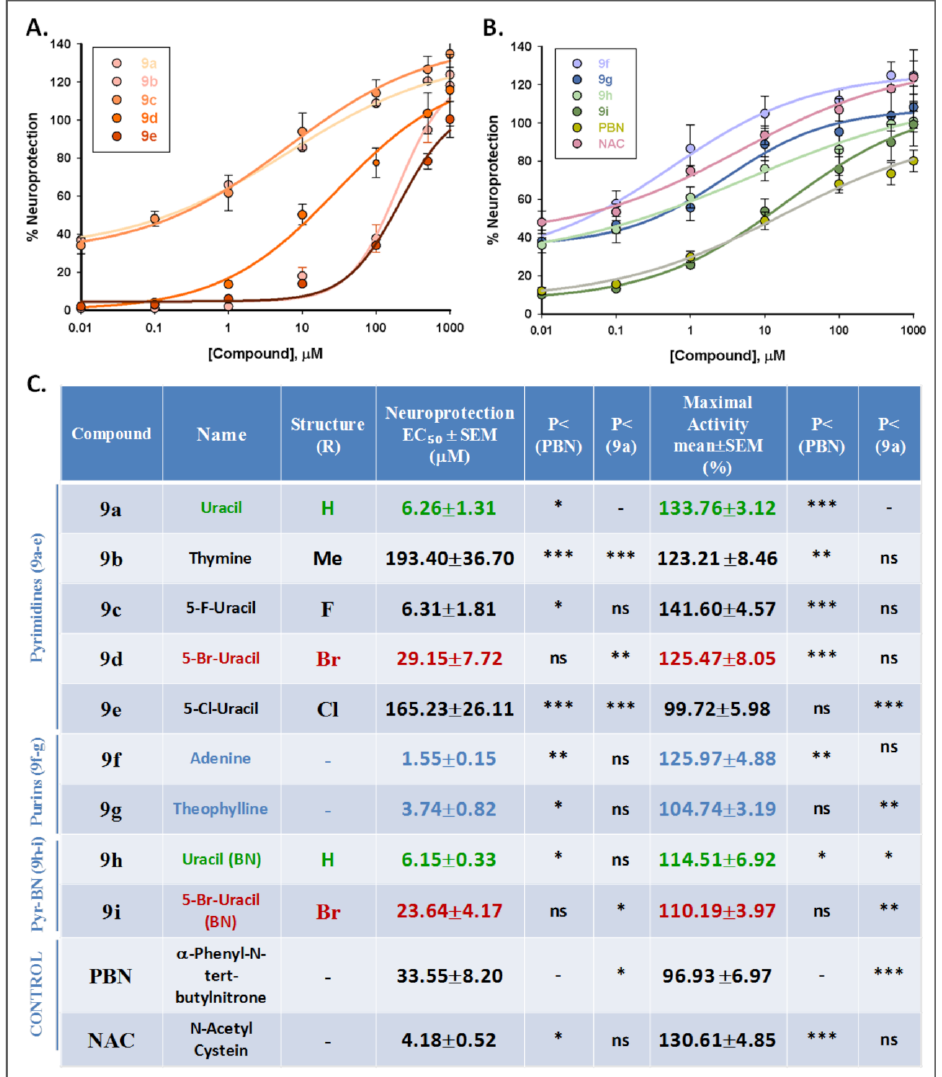
Figure 4. Neuroprotective effects of nitrones 9a – 9i , PBN , and NAC against metabolic cell damage induced by IR treatment in SHSY5Y human neuroblastoma cells. ( A , B ) Concentration-response curves indicating the percent of neuroprotection of different nitrones, 9a – e ( A ), and nitrones 9f – i , PBN , and NAC ( B ) at the specified concentrations. The curve fittings and calculations of EC 50 (cid:48) s and Maximal Activities were performed as described [21]. The data are in terms of the mean ± SEM of the four experiments, each one performed in triplicate. ( C ) EC 50 and Maximal Activity data for the indicated compounds. Statistical comparisons of all data were carried out against PBN and nitrone 9a at * p < 0.05, ** p < 0.01, and y *** p < 0.001 (ANOVA one way); ns—not